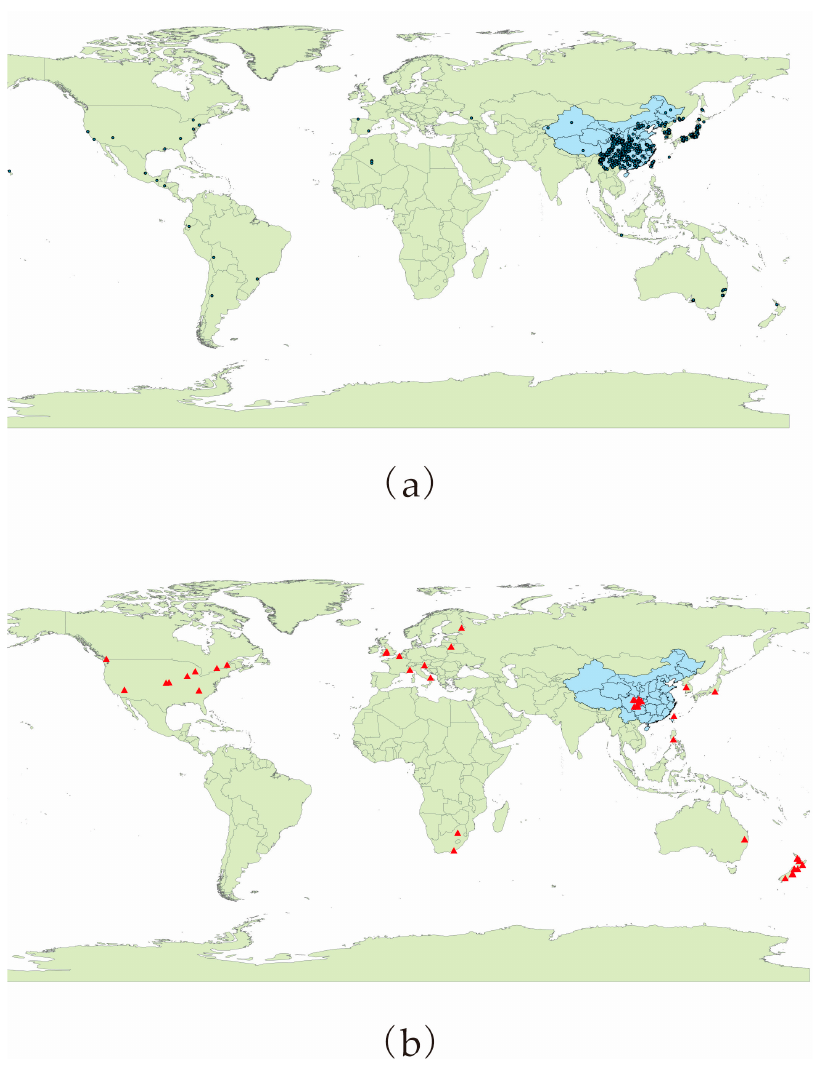
Figure 1. Species occurrence records of P. salicina and M. fructicola . Notes: The black circles for P. salicina ( a ) and red triangles for M. fructicola ( b ) indicate distribution points.